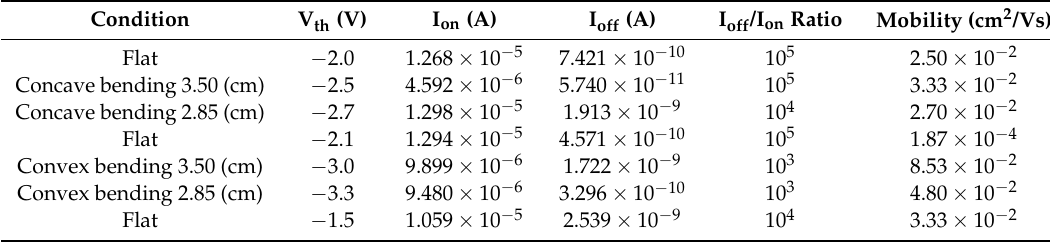
Figure S1: Output characterization of P3HT-based OTFTs with 0.023 wt % blended Y 2 O 3 /chitosan dielectric